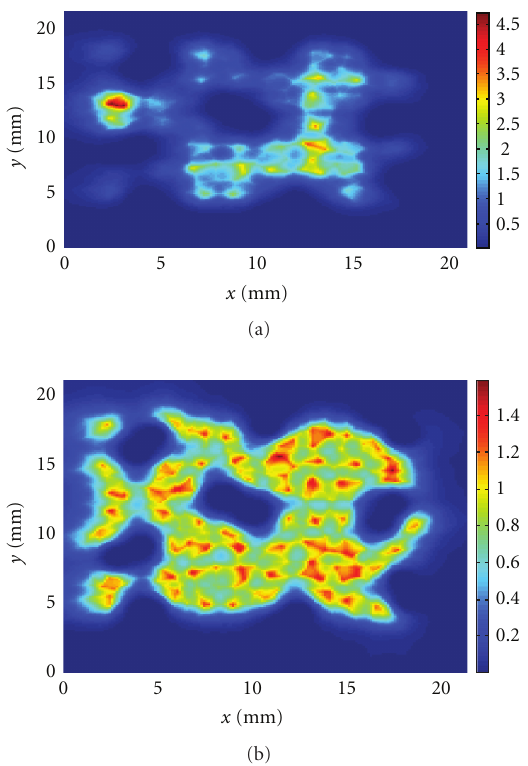
Figure 9: Total thermal dose accumulation in the midplane for the random insonation treatment (a) with fixed power and (b) with variable power.